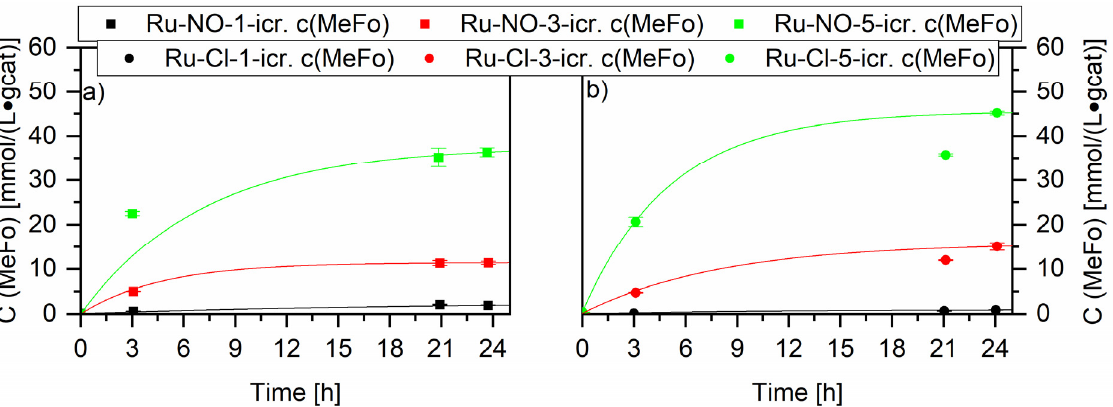
Figure 7. Screening experiments of different Ru loadings on Al 2 O 3 tested in the methanol mediated CO hydrogenation reaction. Graph ( a ) compares the Ru on Al 2 O 3 catalysts impregnated with Ru(NO)(NO 3 ) 3 (squares) and Graph ( b ) compares the Ru on Al 2 O 3 catalysts impregnated with RuCl 3 (circles). Testing conditions: 80 bar, CO:H 2 1:3, 90 °C, 50 mL methanol, quantification: GC-FID (PolyArc).